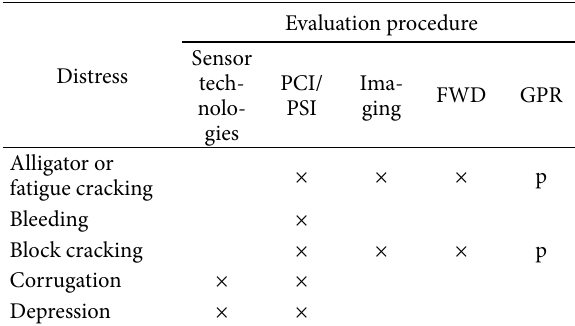
Table 3. Summary of evaluation methods and applicable distresses